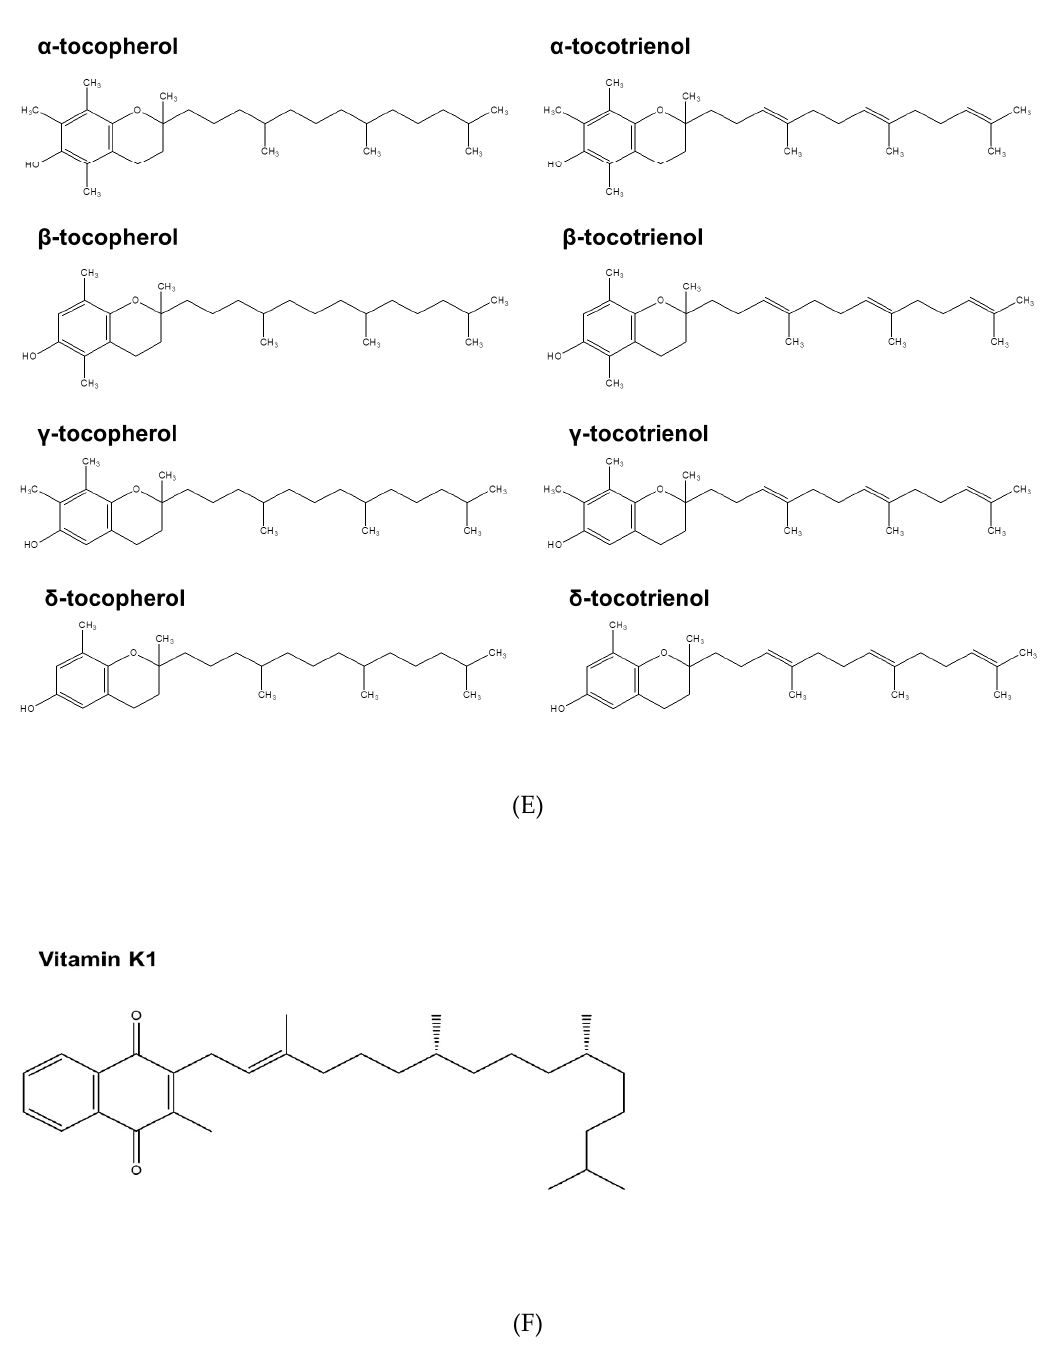
Figure 3. Chemical structures of ( A ) vitamin A; ( B ) vitamin B; ( C ) vitamin C; ( D ) vitamin D; ( E ) vitamin E; and, ( F ) vitamin K. E; and, ( F ) vitamin